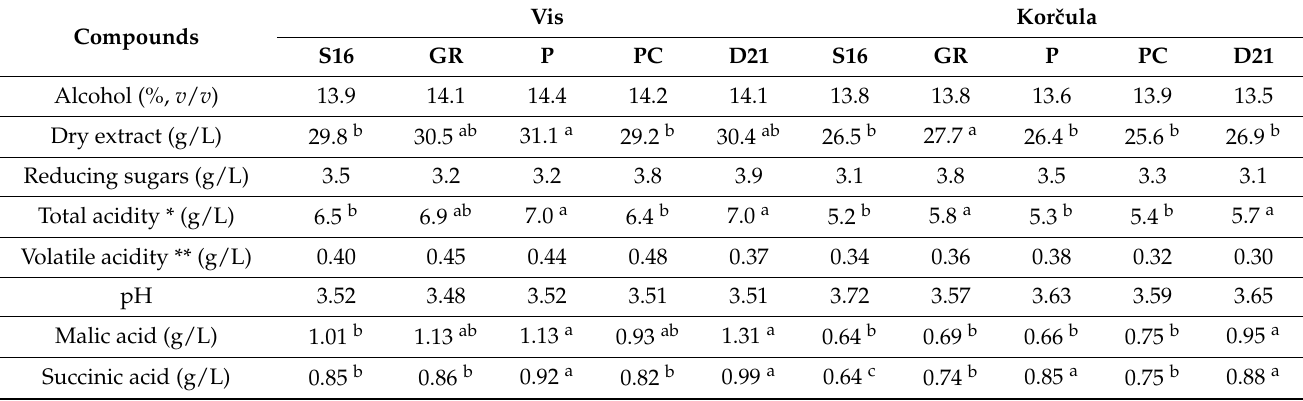
Table 2. Physicochemical properties of Plavac mali